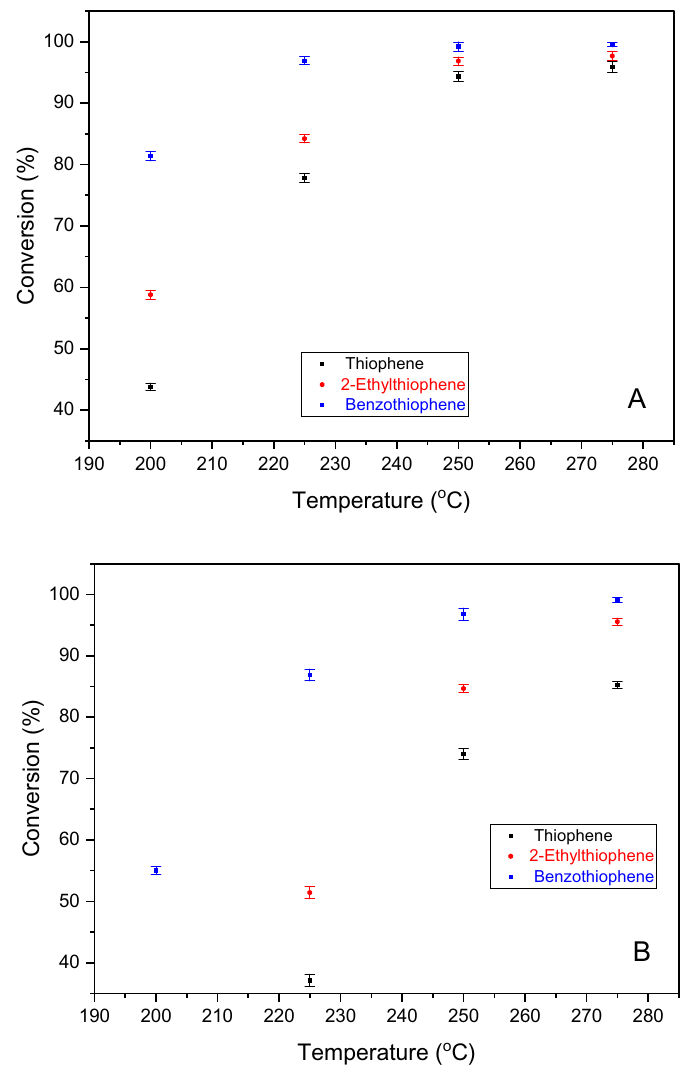
Figure 9. Conversion with temperature over CoMo/γ-Al 2 O 3 catalyst. ( A ) Single sulfur compound HDS (T, 2-ET, BT); ( B ) mixture of sulfur compounds HDS (T + 2-ET +